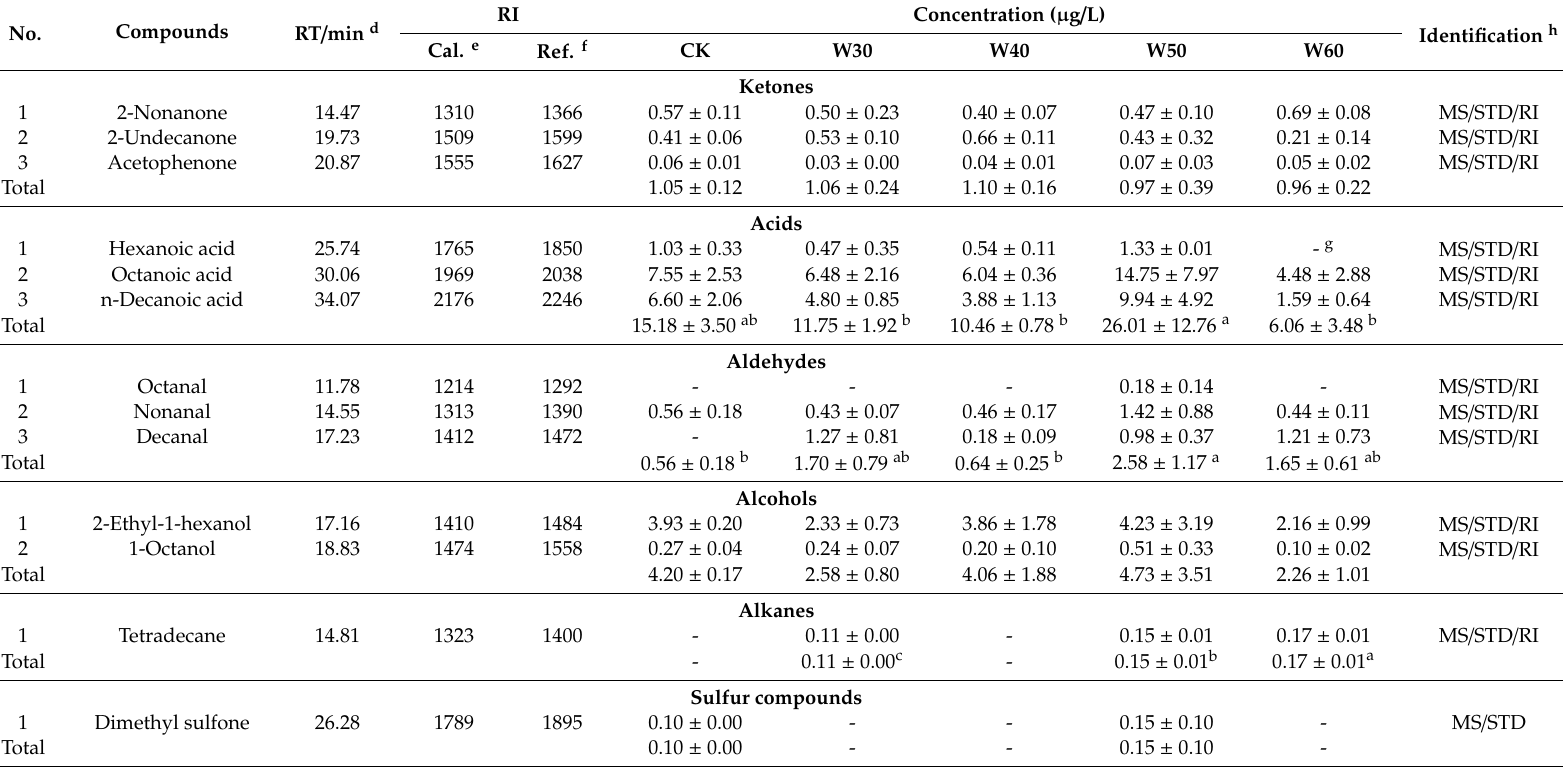
Table 2. Volatile compounds identified by GC-MS in skim milks with di ff erent preheating